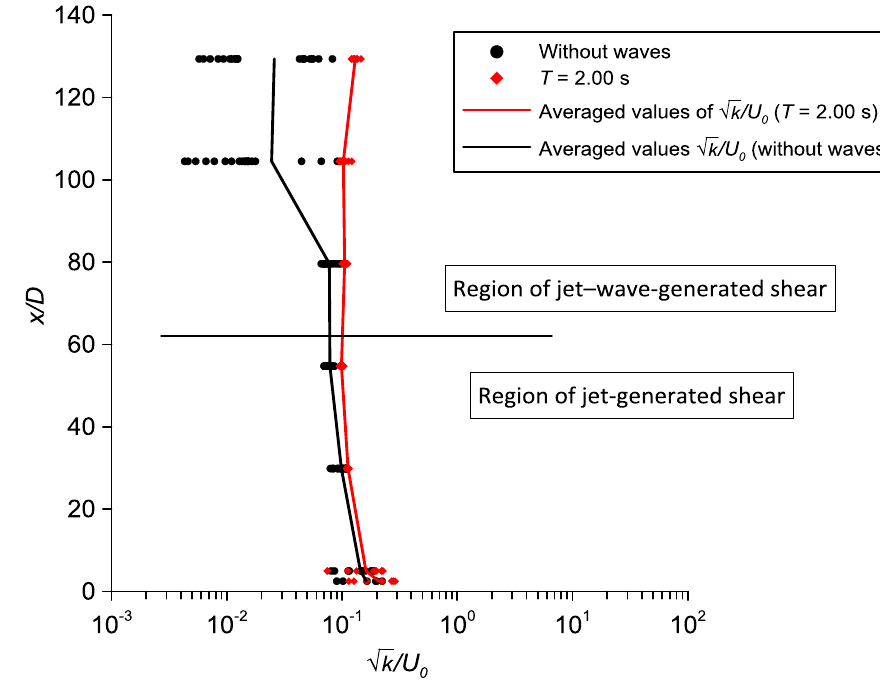
Figure 9. Values of k 0.5 /U 0 with the definition of the region with jet-generated turbulence (at the bottom) and the region with jet–wave-generated turbulence (at the top).